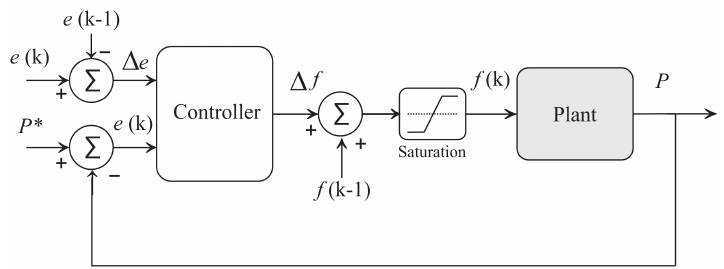
Figure 4. Fuzzy Pressure Control System.